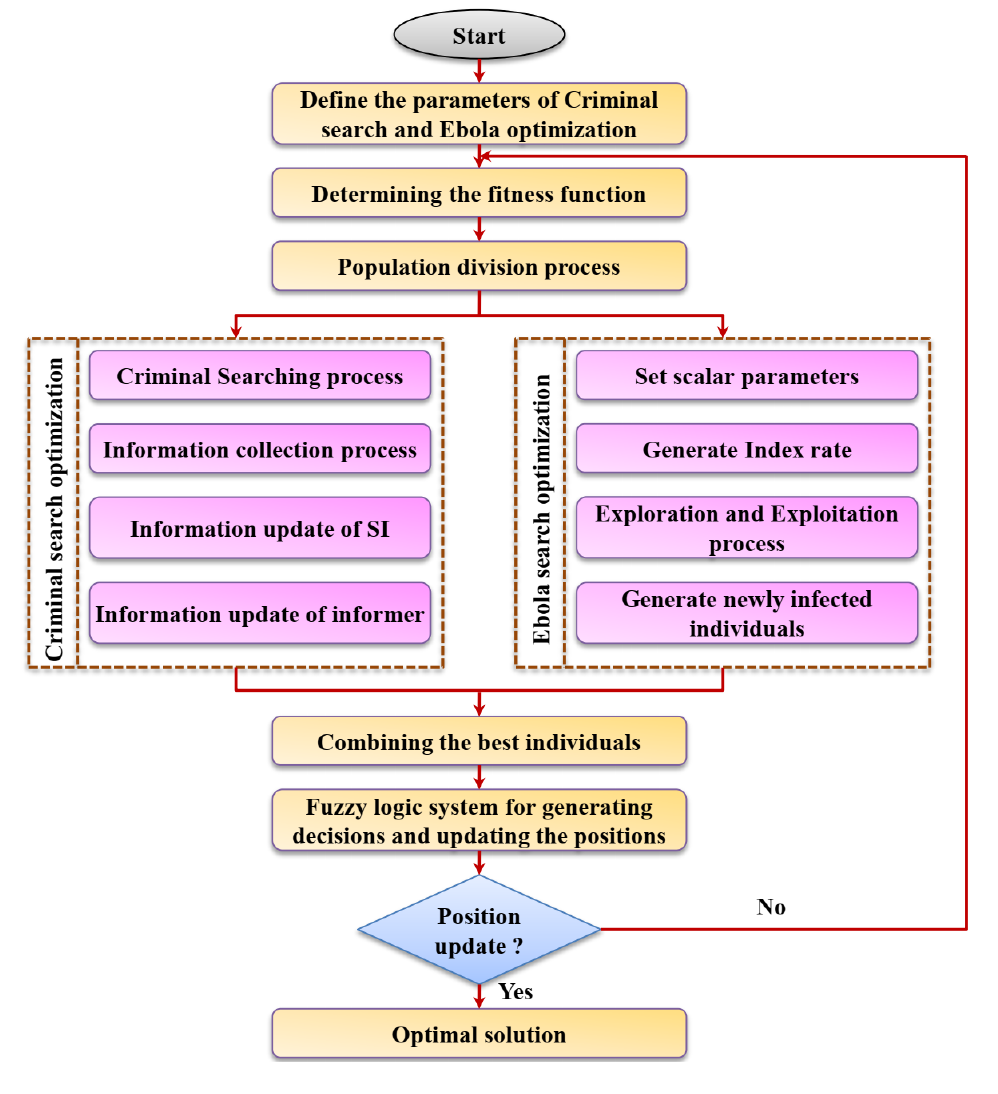
Figure 2. Formulation of the FCSEO algorithm.